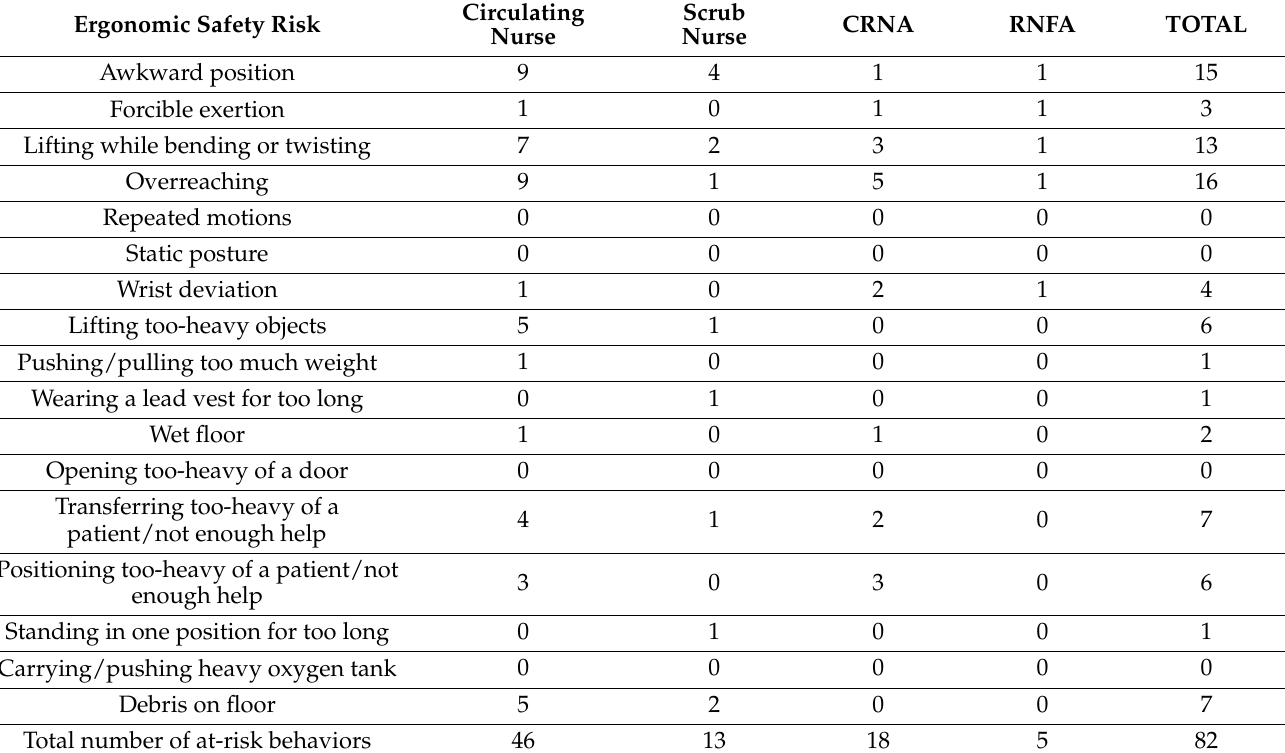
Table 1. At risk safety issues by perioperative